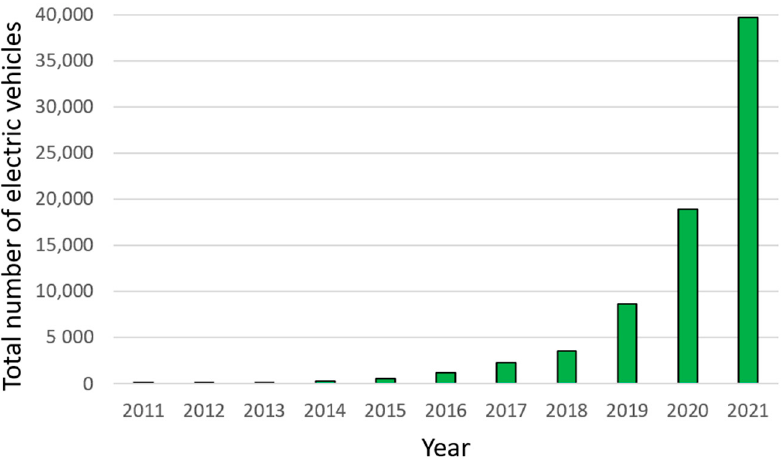
Figure 2. Total number of EVs in Poland.